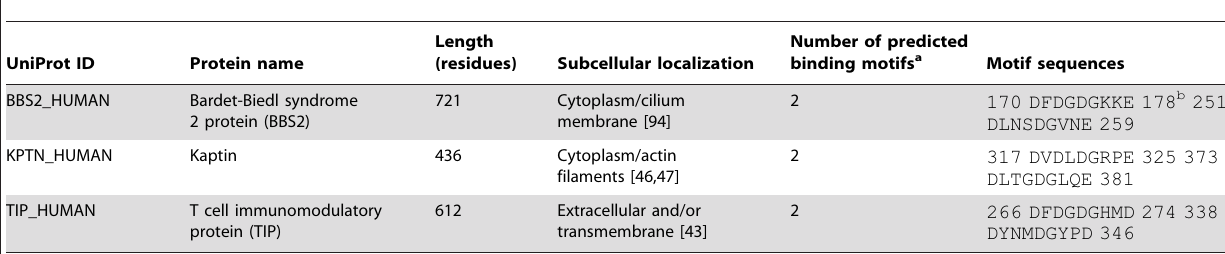
Table 2. Novel putative calcium blades in human